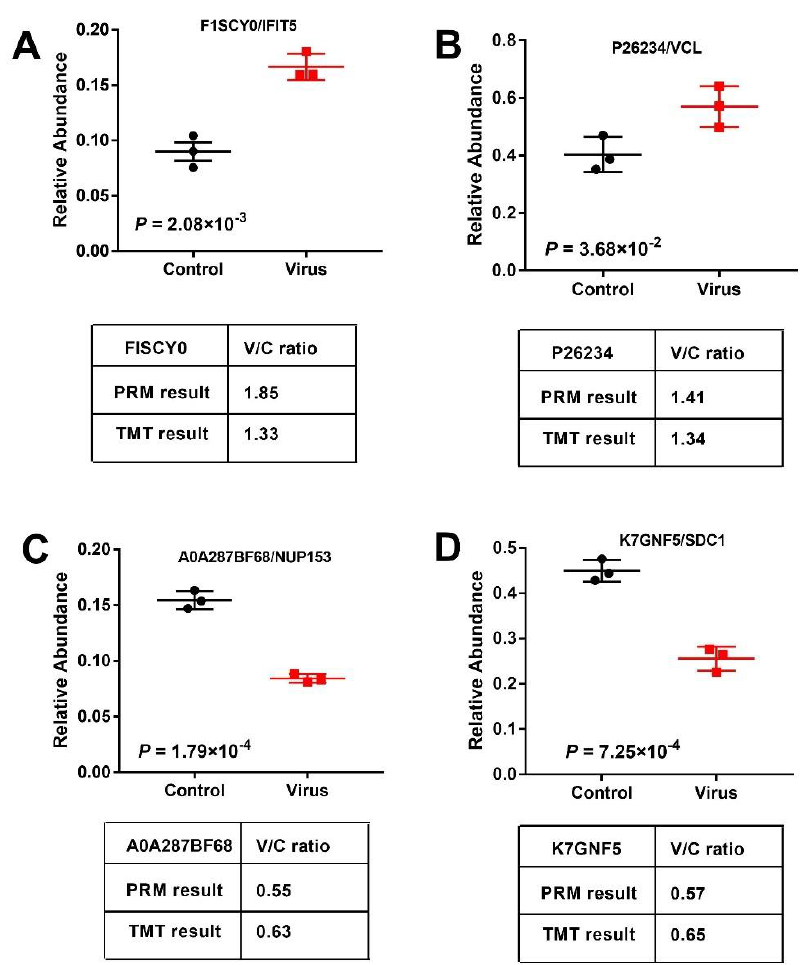
Figure 6. DEPs including induced protein with tetratricopeptide repeats 5 ( A , IFIT5), vinculin ( B , VCL), nucleoporin ( C , NUP153), and syndecan-1 ( D , SDC1) were verified using PRM and the virus/control (V/C) ratio was compared with the TMT result. Data are expressed as mean ± SD for three replicates.